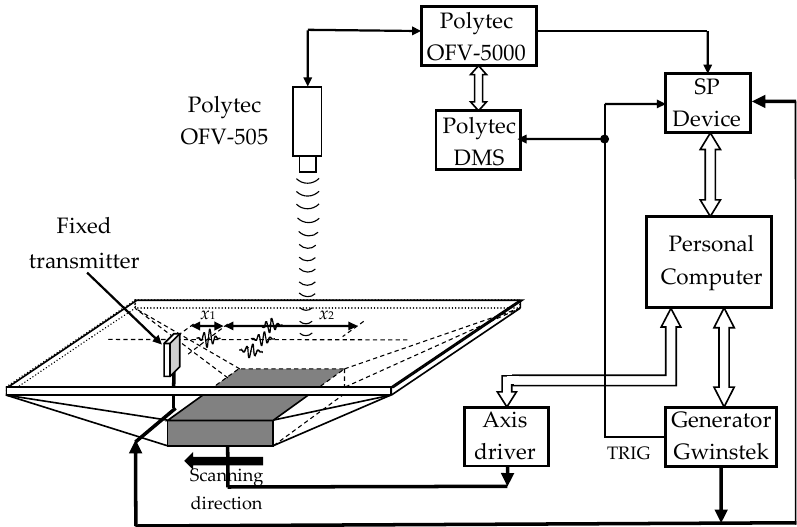
Figure 8. Structural scheme of the Lamb wave A 0 mode signal generation and recording in thin PVC film.